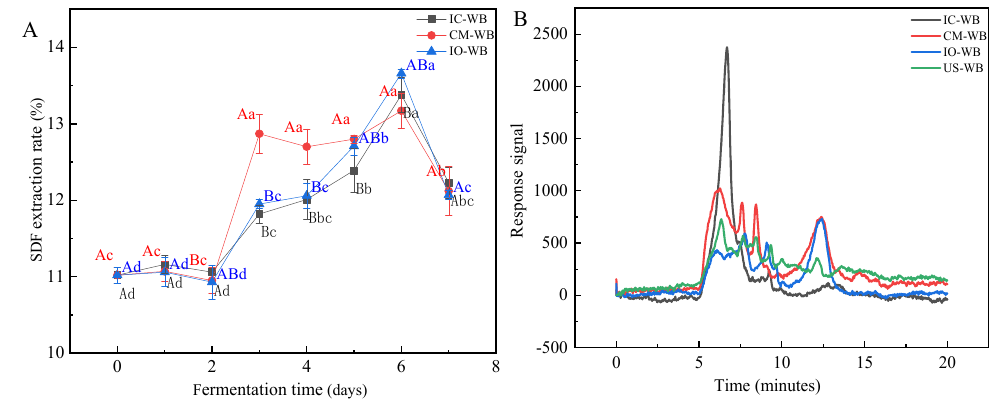
Figure 1. The extraction yield and molecular weight of soluble dietary fiber (SDF) in fermented wheat brans made using different microorganisms. ( A ) The extraction yield, ( B ) the molecular weight. Different lowercase letters indicate significant differences at p < 0.05 in terms of fermentation time. Different capital letters indicate significant differences at p < 0.05 in terms of microorganisms. IC-WB, Isaria cicadae Miq. fermented wheat bran; CM-WB, Cordyceps militaris fermented wheat bran; IO-WB, Inonotus obliquus fermented wheat bran; US-WB, unfermented sterilized wheat bran.